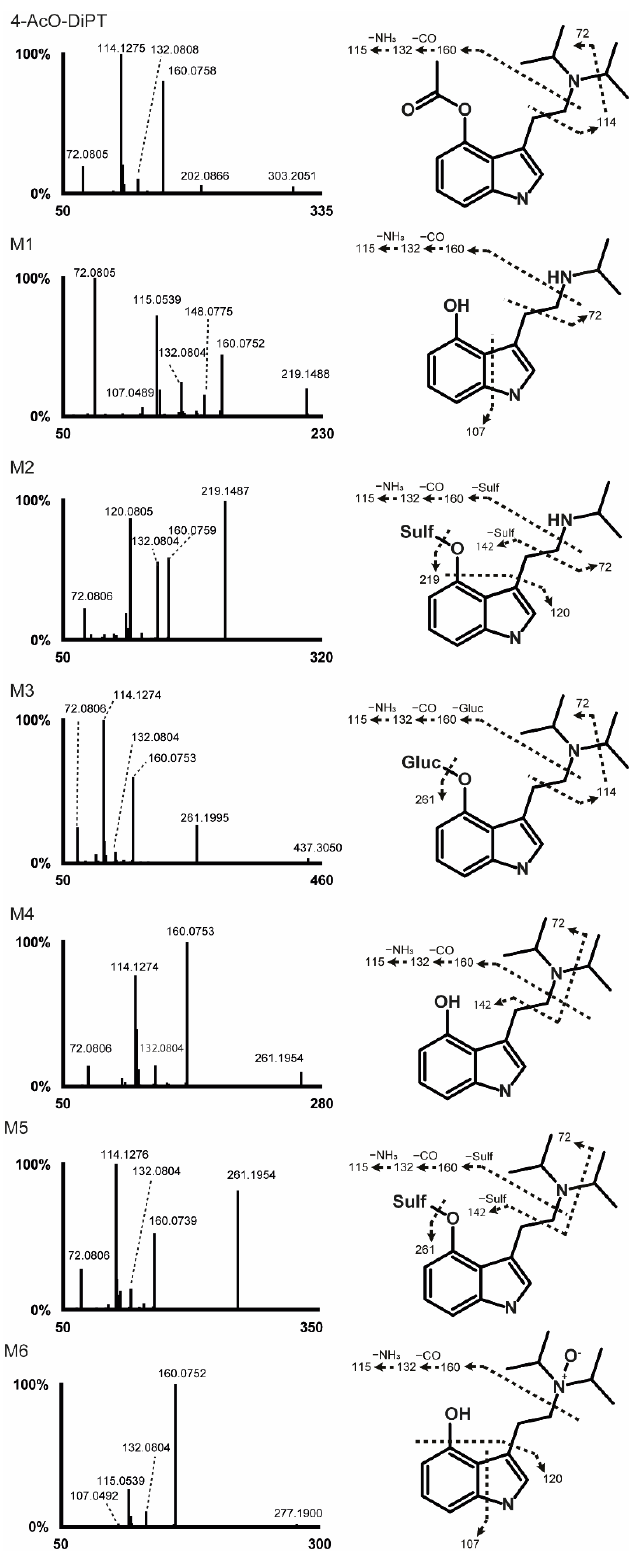
Figure 1. 4-AcO-DiPT high-resolution tandem-mass-spectrometry spectrum and suggested fragmentation in positive-ionization mode.